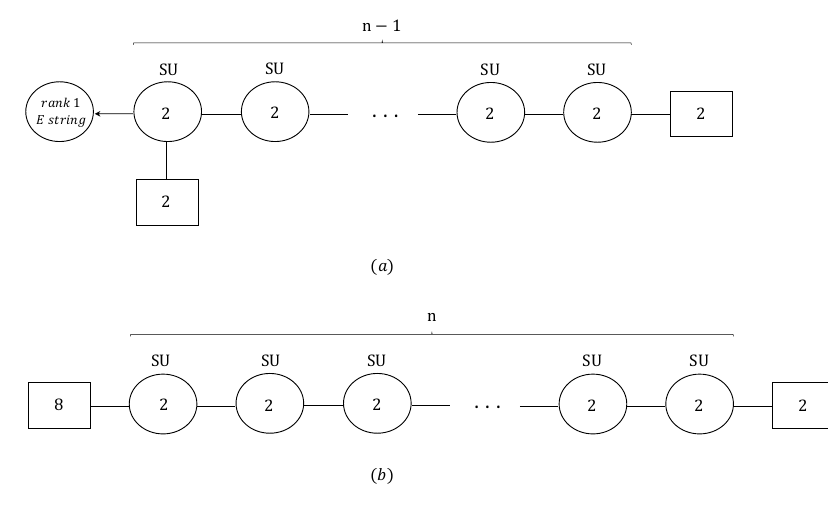
Figure 1 . The low-energy description on the tensor branch of the 6 d SCFTs associated with Z 2 orbifolds of E-string. Here, the nodes with a number in them stand for SU groups whose rank is that number minus one. Quiver (a) describes the case of SU(2) (cid:2) E 7 preserving embeddings while quiver (b) the case of SO(16) preserving embeddings. In quiver (a) the arrow into the rank 1 E-string theory represents gauging an SU(2) (cid:26) E 8 of the global symmetry of the E-string theory. Also, here n is the number of M5-branes in the brane